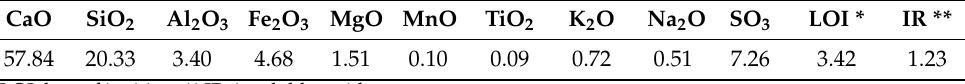
Table 3. Chemical composition (wt.%) of tested ordinary Portland cement